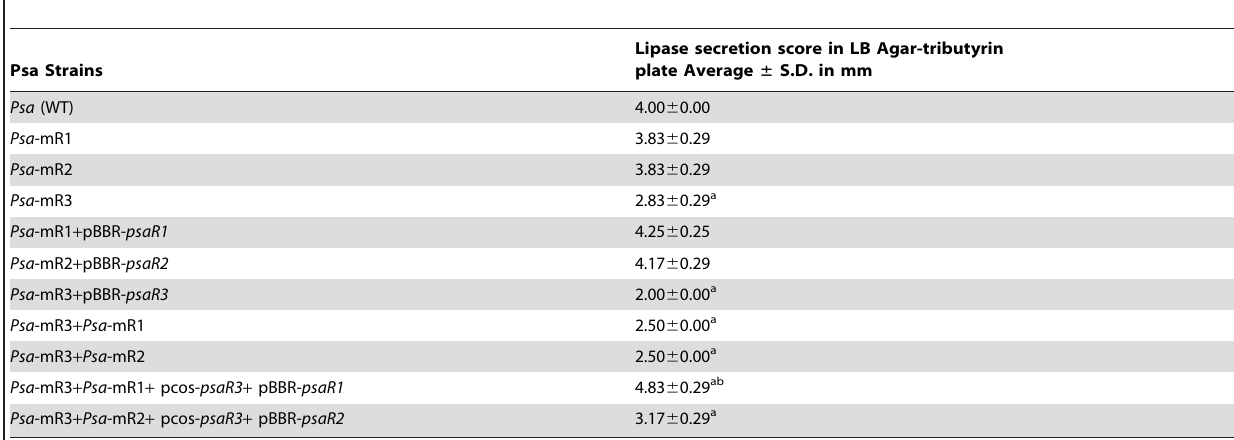
Table 6. Lipase secretion score of Pseudomonas syringae pv. actinidiae